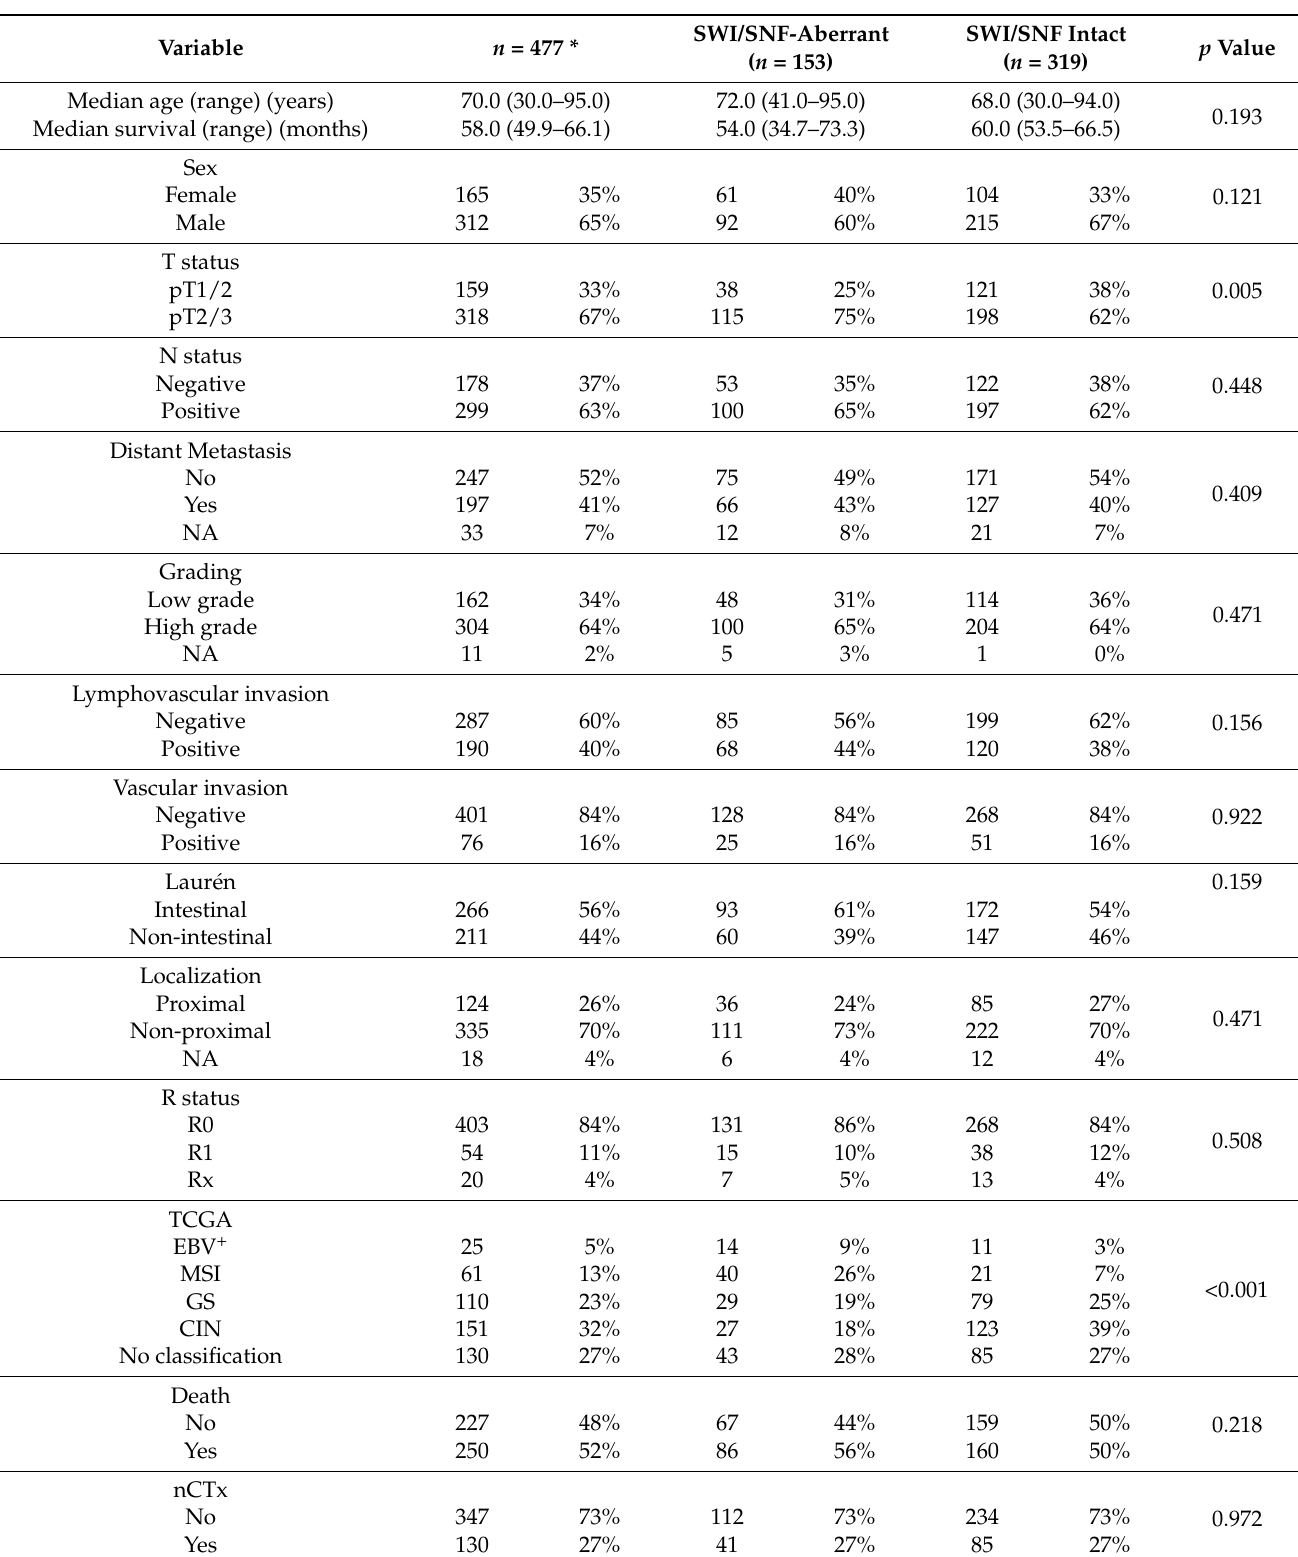
Table 1. Clinocopathological characteristics and SWI/SNF